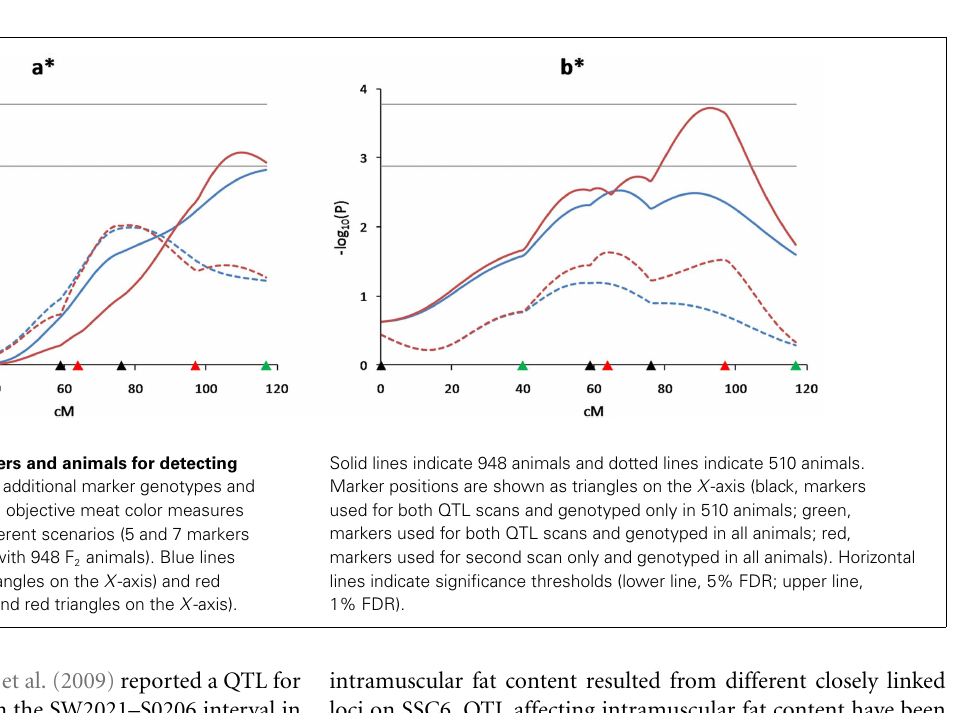
FIGURE 5 | Effect ofadditional markers and animals for detecting meat color QTL on SSC12. Effects of additional marker genotypes and animals for detecting QTL for a ∗ and b ∗ objective meat color measures on SSC12 were compared under 4 different scenarios (5 and 7 markers with 510 F 2 animals, 5 and 7 markers with 948 F 2 animals). Blue lines indicate 5 markers (black and green triangles on the X -axis) and red lines indicate 7 markers (black, green and red triangles on the X -axis).